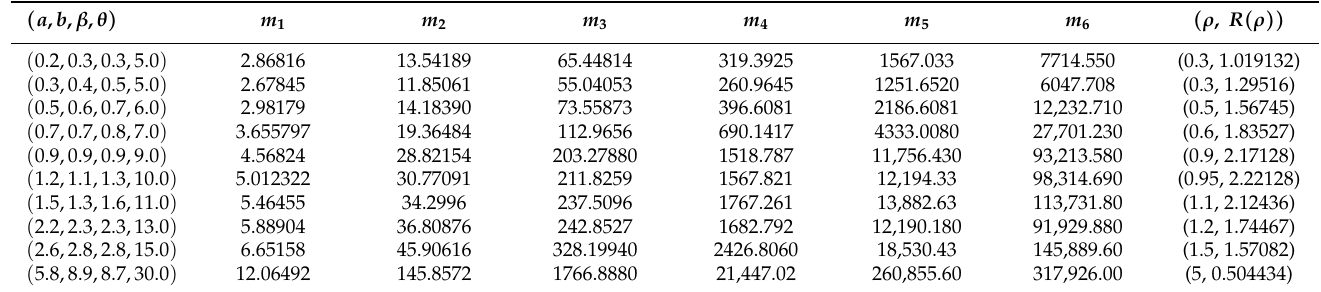
Table 3. Some possible numerical values of the first six moments and Rényi entropy of the NEKwU distribution for some parameter